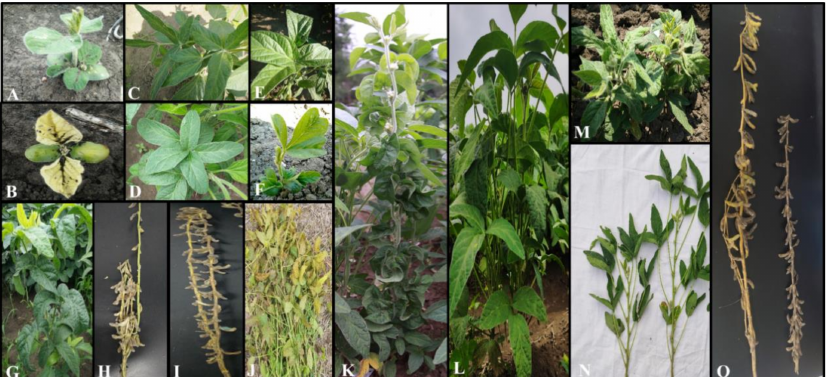
Figure 3. Examples of phenotypes observed in 12 C 6+ carbon ion beam-induced soybean population. ( A ) Yellowing unifoliolate leaves mutant. ( B ) Two pairs of unifoliolate leaves mutant. ( C , D ) Pentafoliate leaves mutant. ( E ) Terafoliate leaves mutant. ( F ) Deformed leaves mutant. ( G ) Leaves bent downward mutant. ( H ) Multibranches mutant. ( I ) Double main stem mutant. ( J ) Sterile plants mutant. ( K ) Rolled leaves and short petioles mutant. ( L ) Control plants. ( M ) Multileaves mutant. ( N ) Short height mutant (on the right is the control). ( O ) Short growth period mutant (on the left is the